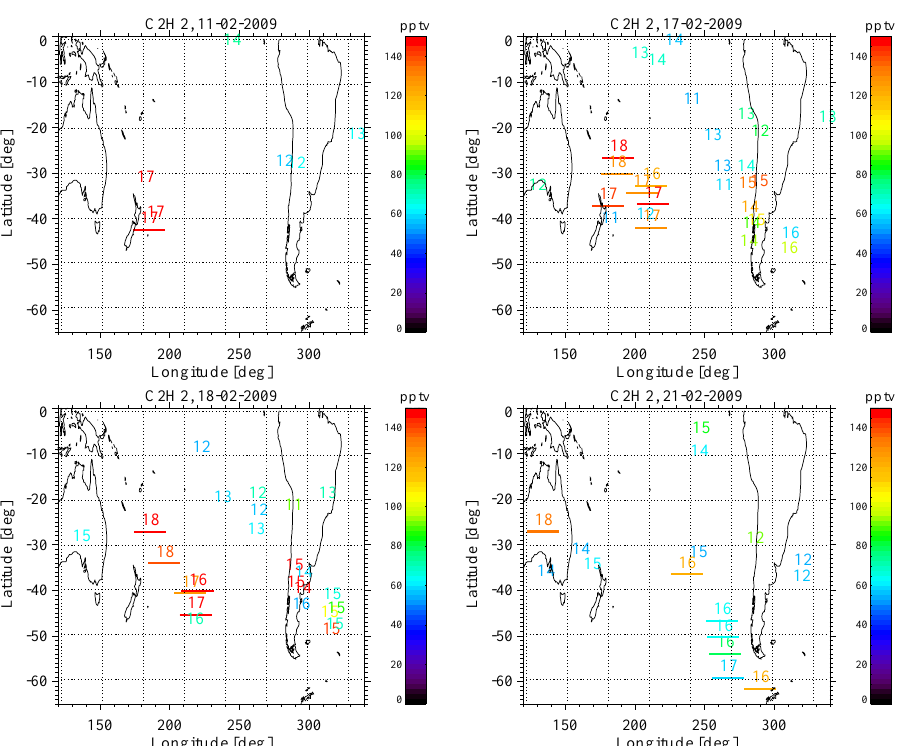
Fig. 13. Geometrical height (in km, denoted by numbers) of maxima of measured C 2 H 2 profiles from 11, 17, 18, and 20 February 2009 (top left to bottom right). Volume mixing ratios are colour coded, and only maxima above 50pptv are presented. Maxima, which are 1km or more above the tropopause, derived from MIPAS temperature profiles, are